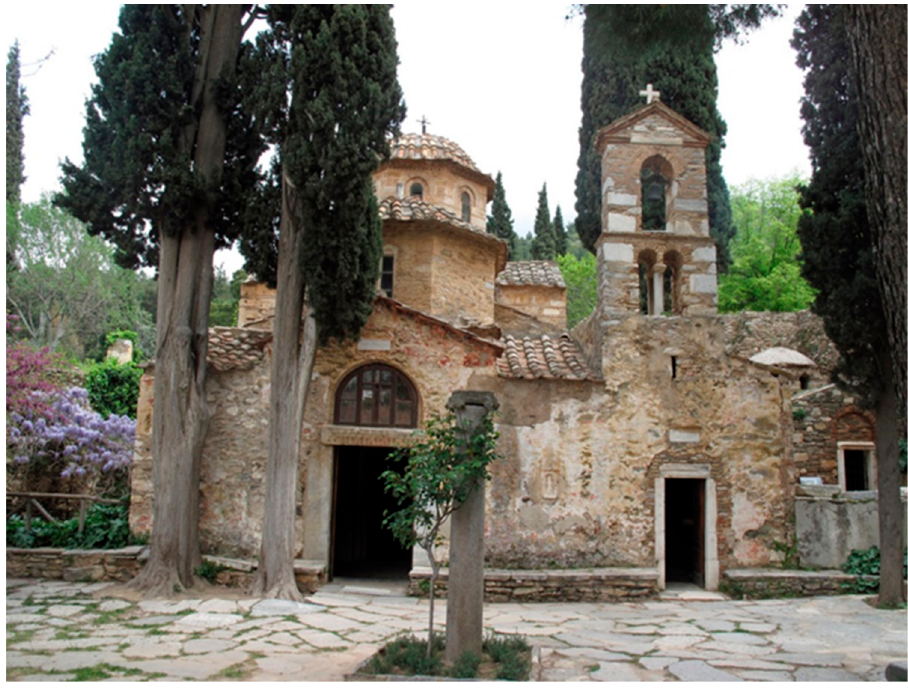
Figure 46. Front view of Kaisariani Monastery.